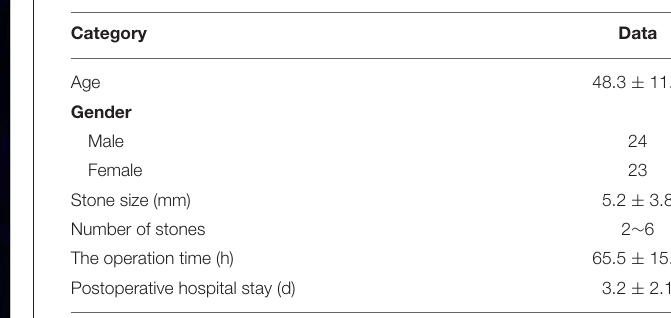
TABLE 1 | Patients information and perioperative situation ( n =